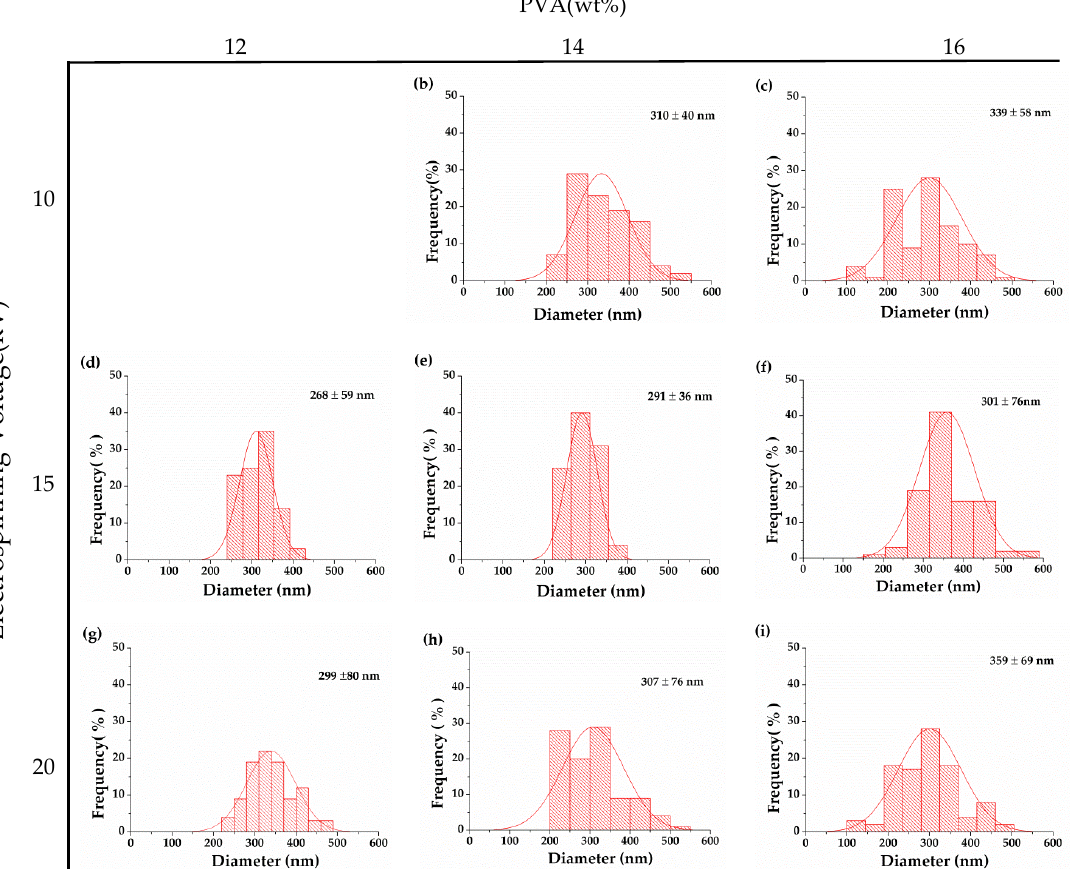
Figure 3. Diameter distribtuion of nanofibrous membranes with different combinations of concentration of PVA solution (column: 12, 14, and 16 wt%) and spinning voltage (row: 10, 15, and 20 kV).